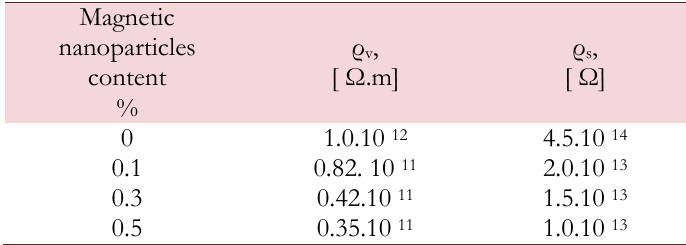
Table 2 : Variation of ρ v and ρ s in dependence on the magnetic nanoparticles content